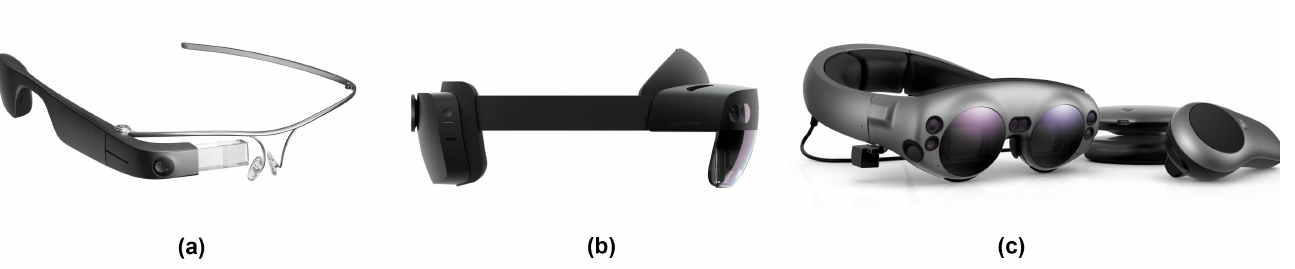
Figure 3. Images of the prominent commercially available optical see-through head-mounted